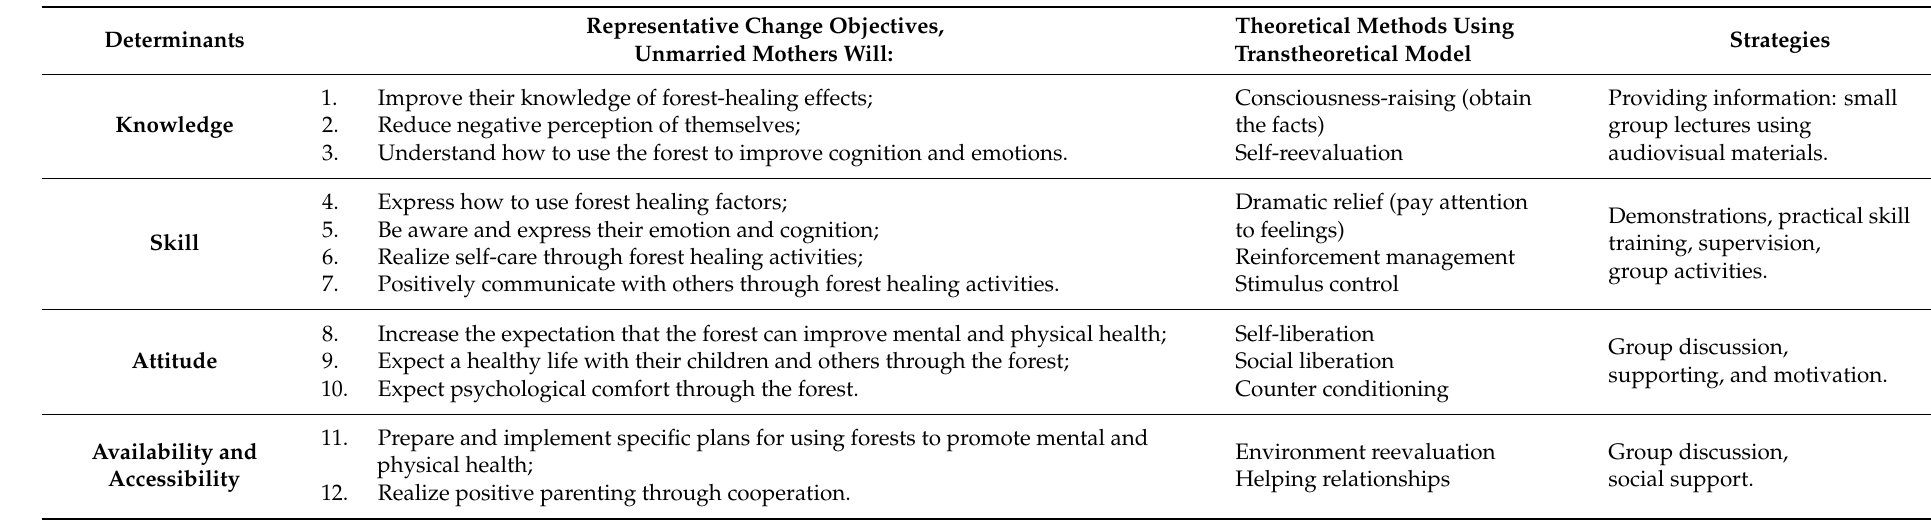
Table 4. Theoretical Methods, Strategies, and Practical Applications.